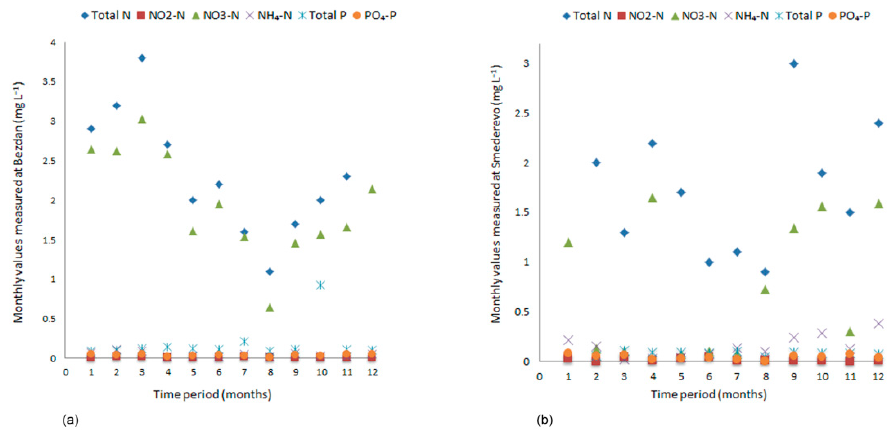
Figure 3. ( a ) Monthly variations in the level of nutrient content during the year at the site of Bezdan; ( b ) monthly variations in the level of nutrient content during the year at the site of Sme- derevo.